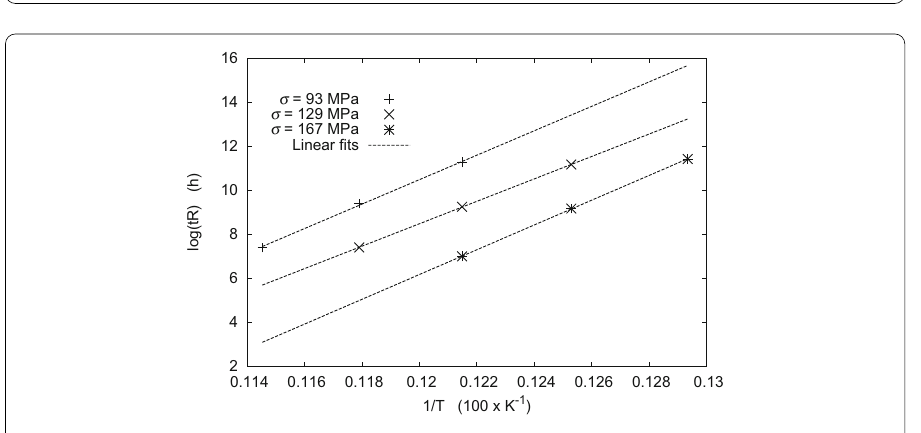
Fig. 8 Experimental curve and linear fit for a 2 ( μ ) and b 2 ( μ ) (from Ref. [61])